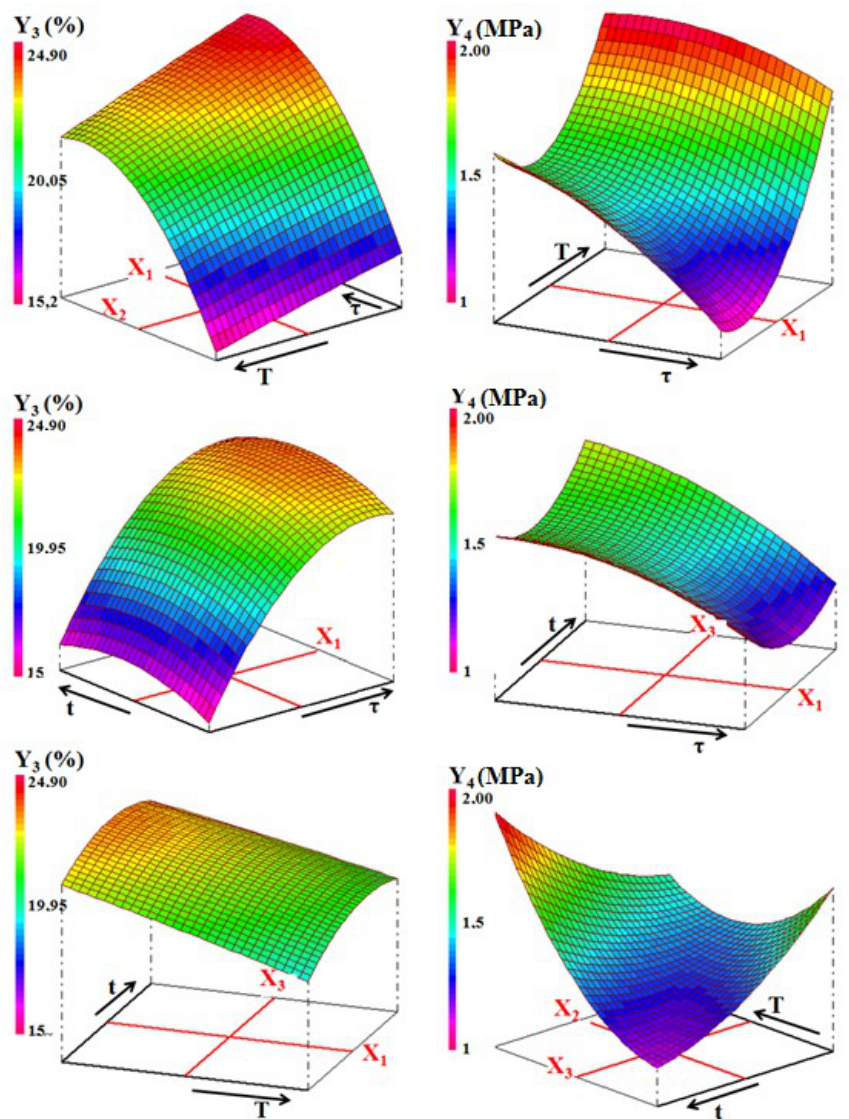
Figure 13. Variation of the water absorption ( Y 3 ) and compressive strength ( Y 4 ) of the ternary blends.